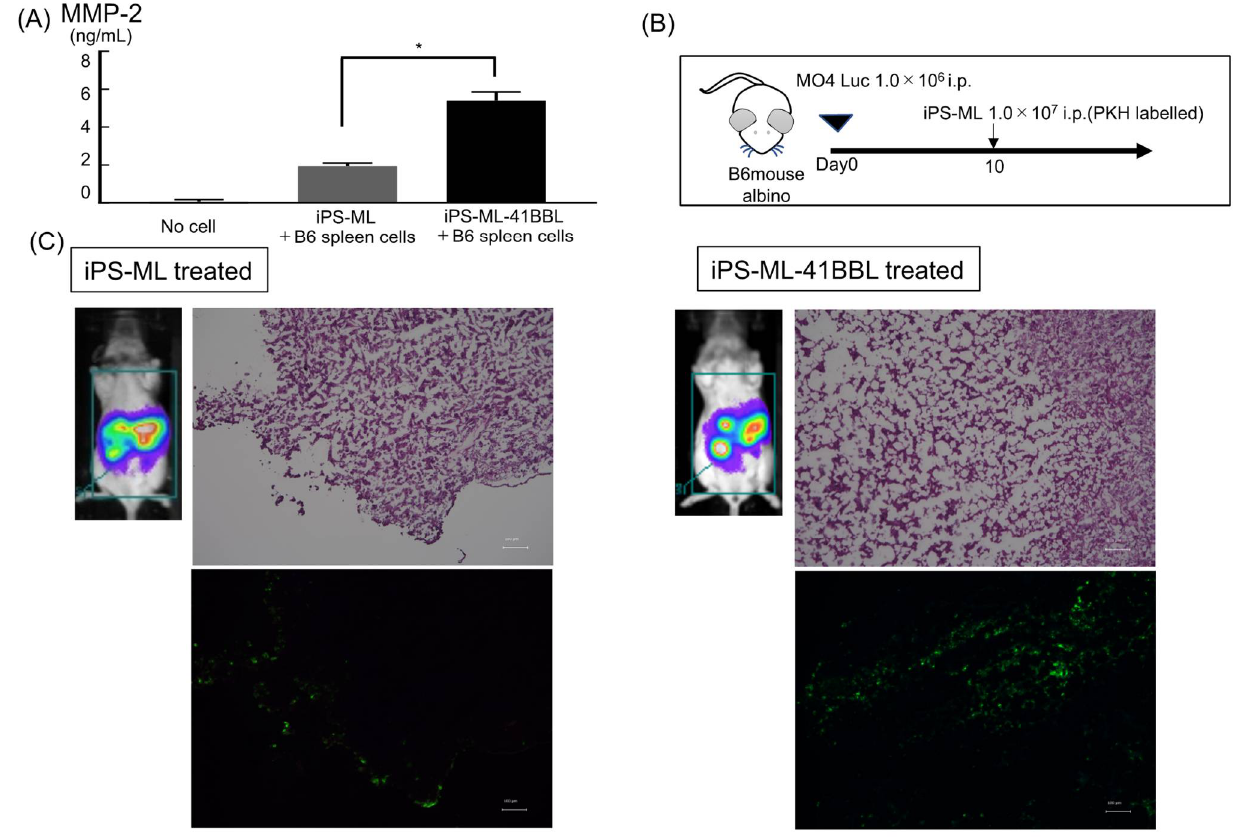
Figure 4. Infiltration of iPS-ML-41BBL in established tumor tissues in the mouse peritoneal cavity. ( A ) Analysis of levels of MMP-2 in the supernatant obtained from the cocultured spleen cells and iPS-ML or iPS-ML-41BBL using MMP-2–specific ELISA. The sampling schedule is the same as in Figure 1C. ( B ) The model of treatment schedule; luciferase-expressing MO4 cells were intraperitoneally injected into B6-albino mice (1.0 × 10 6 cells/mouse). ( C ) Luminescence imaging analysis in mice. Scale bar: 100 µm. Tumor tissues were analyzed using a fluorescence microscope BZ-X700. * p < 0.05.